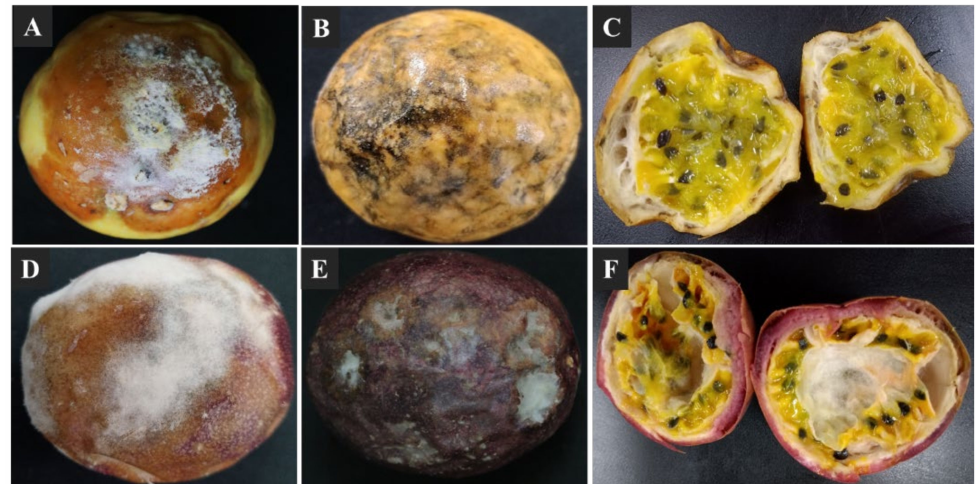
Figure 1. Postharvest decay symptoms on yellow and purple passion fruit; ( A , D ) visible soft decay symptoms causing soggy fruit; ( B , E ) visible dry and irregular decay symptoms; ( C , F ) cross-sections of decayed passion